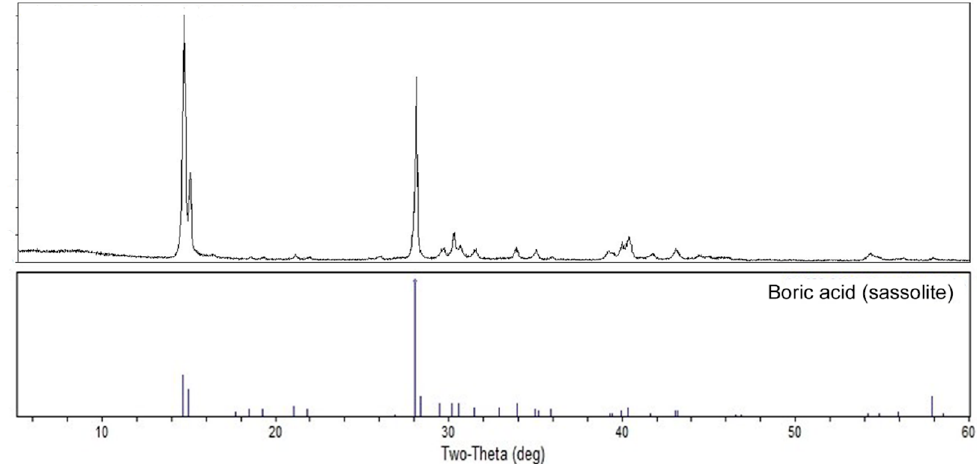
Figure 7. PXRD pattern of the solid evaporite obtained from the clear filtrate of a 0.05 wt% suspension of ZnB 3 O 4 (OH) 3 after 72 h ( top ), and a reference pattern for boric acid ( bottom ).